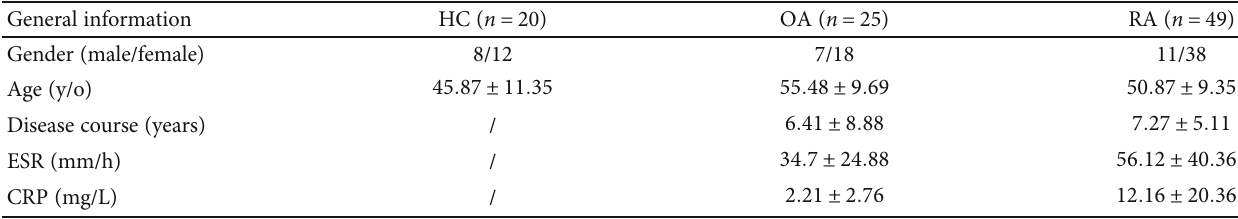
Table 1: General information of patients and health controls recruited for ELISA in this study.